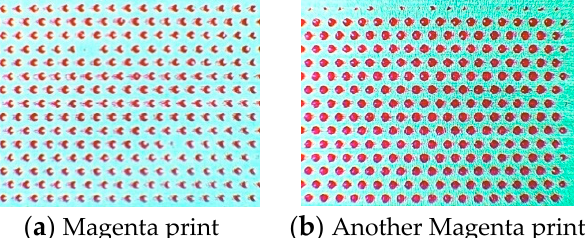
Figure 12. Example of results for two print samples printed with a cell angle of 60°. ( a ) % of dots belonging to category ID1 (0%), ID2 (92%), ID3(2%), ID4 (less than 1%), ID5 (0%), ID6 (5%, most of them are at right of the figure). There are two missing dots. In total, 92% of dots have a circular shape—see statistical values report in Table 1. ( b ) % of dots belonging to category ID1 (less than 1%), ID2 (0%), ID3 (less than 1%), ID4 (40%), ID5 (49%, all have a circular shape), ID6 (6%, most of them are the top of the figure). There is no missing dot. In total, 94% of dots have a circular